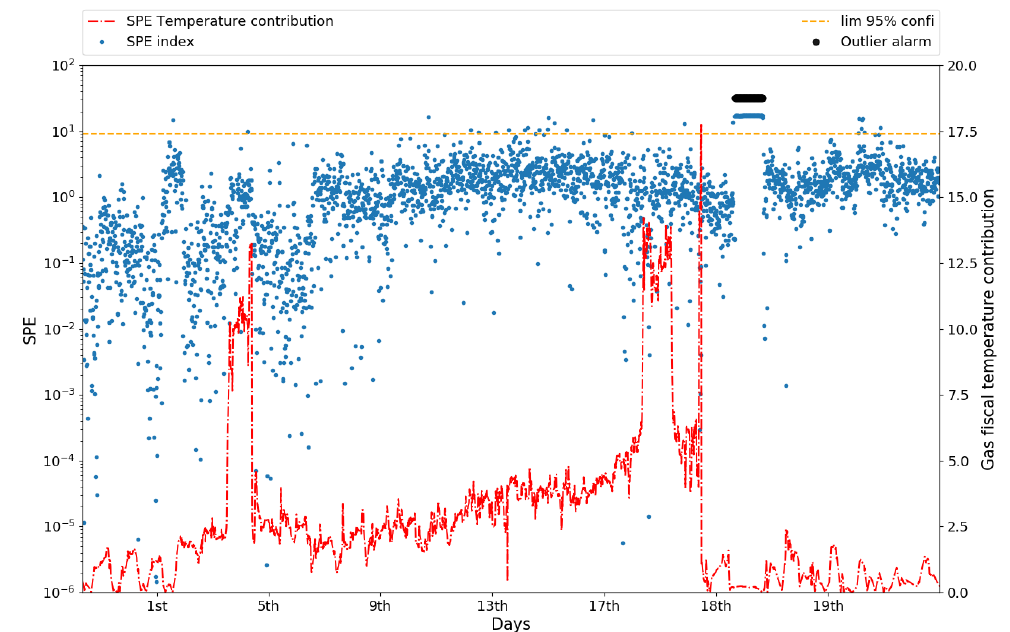
Figure 6. SPE statistic for the sensor fault in Fiscal Metering Station II during one month. In red, the dynamic behavior of the gas fiscal temperature contribution to SPE. Black dots represent fault alarm activation. The orange dashed line is the detection